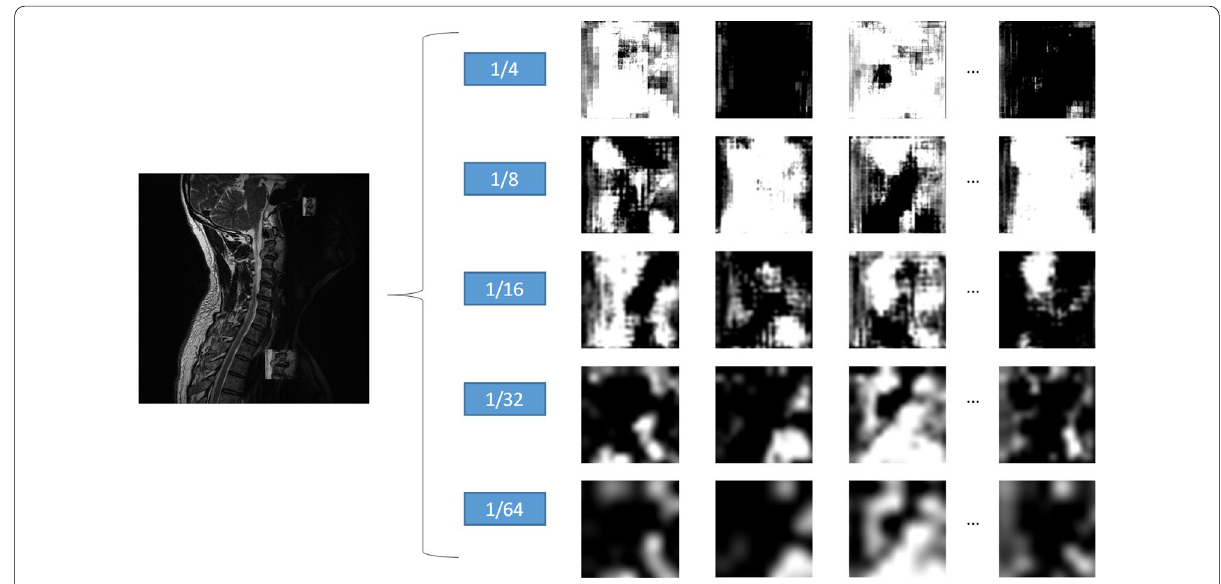
Fig. 3 Feature maps extracted with five